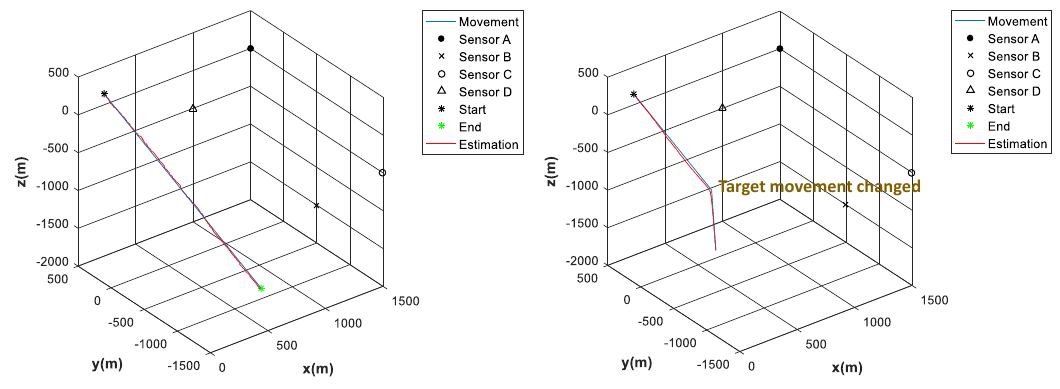
Figure 8. Verification of PF using